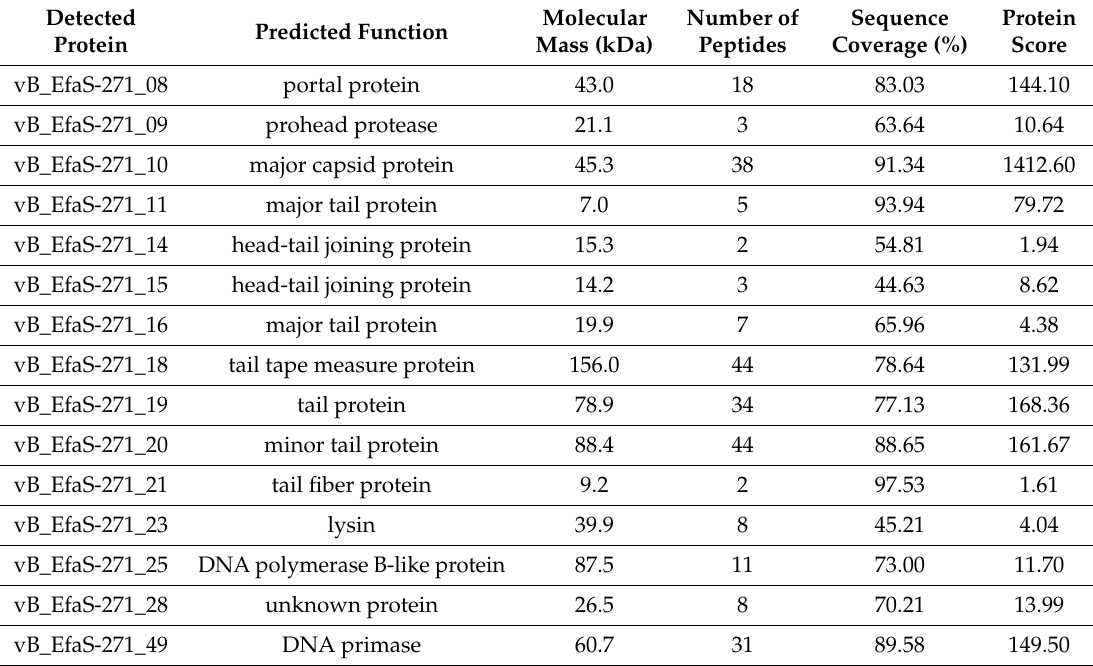
Table 2. Mass spectrometry analysis of vB_EfaS-271